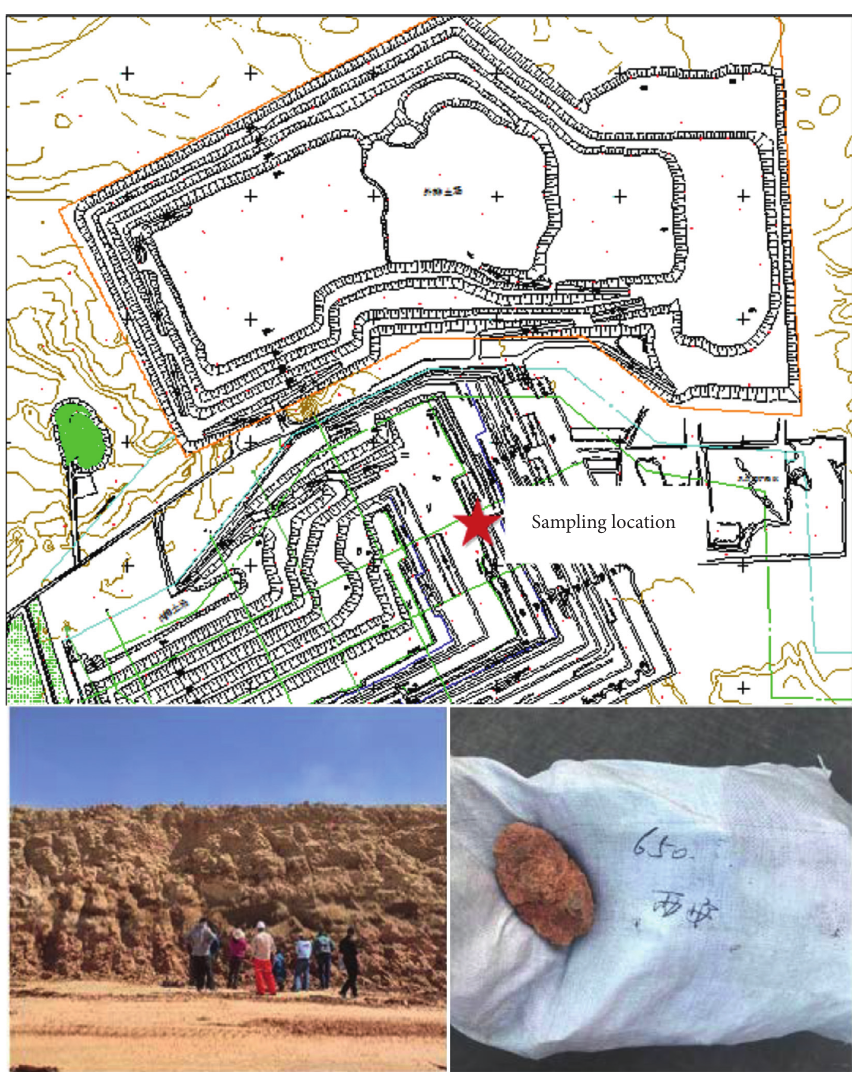
Figure 3: On-site rock sample collection.